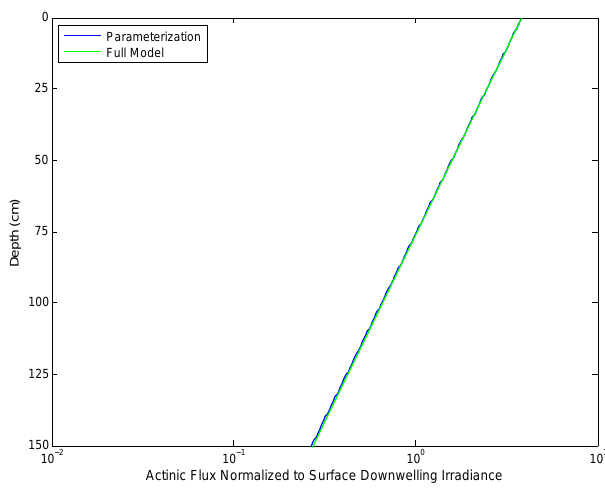
Fig. 2. Actinic flux profile normalized to surface downwelling radiation determined by our parameterization (Eq. 18) and the full model (Grenfell, 1991) for a representative deep (depth > 3m) snowpack. For this comparison, the incident radia- tion field is entirely diffuse, λ = 305nm, θ = 60°, r e = 100µm, C BC =0.3ngg − 1 , and C nonBC =0ngg − 1 . For an isotropic radia- tion field, the ratio of actinic flux to surface downwelling radiation is equal to 4. This ratio is somewhat less than 4 for the present cases depending on the solar zenith angle and amount of cloud